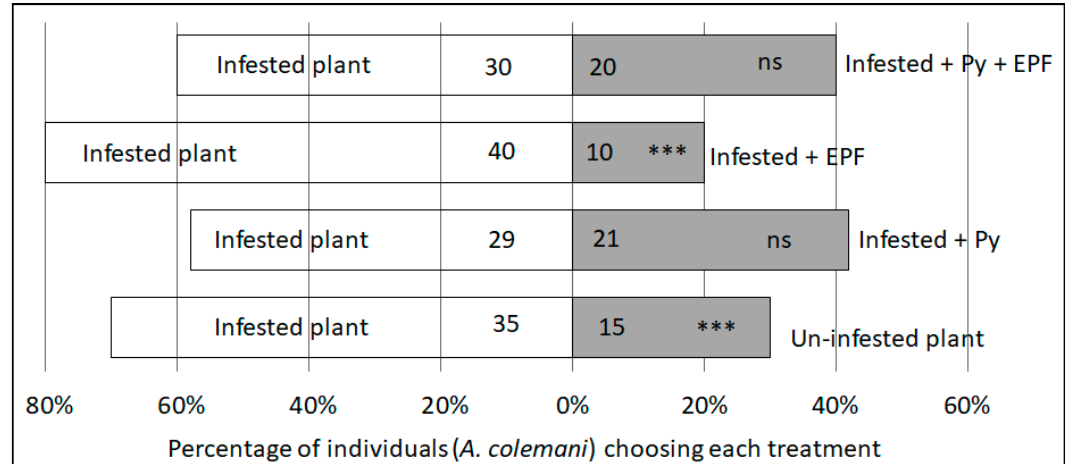
Figure 4. Parasitoid, A. colemani , responses to treatments in a Y-tube olfactometer. N = 50 for each treatment, with the number of individuals choosing each side indicated on the relevant bar. Where ‘Infested’ refers to aphid colonized plant, Py is treatment with pyrethrum and EPF is treatment with entomopathogenic fungi, Metarhizium anisopliae (ICIPE 62) *** Indicates P < 0.01, ns = not significant.